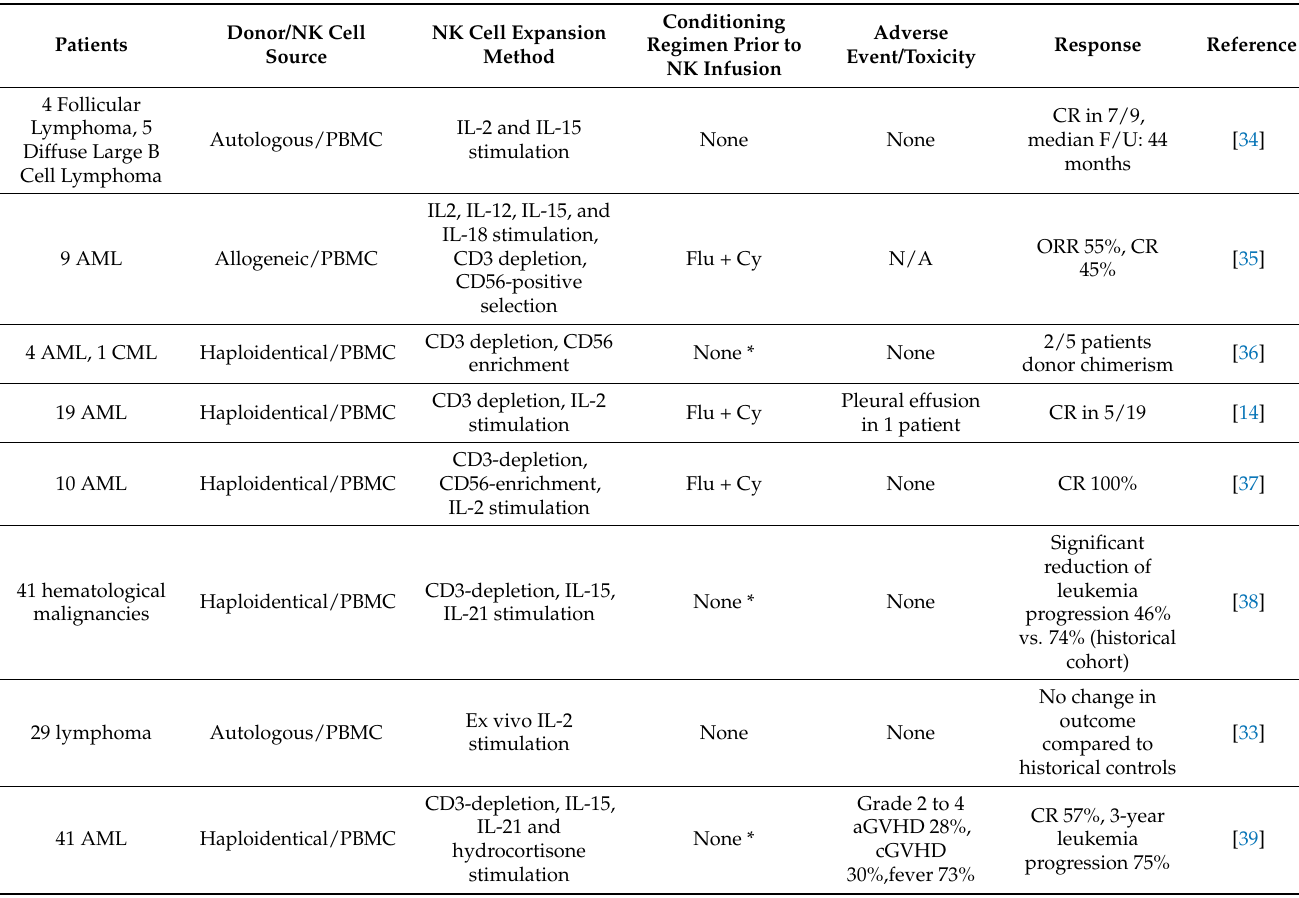
Table 1. Clinical trials with administration of autologous and allogeneic NK cells (aGVHD: Acute Graft versus Host Disease, AML: Acute Myeloid Leukemia, cGVHD: Chronic Graft versus Host Disease, CR: Complete Response, CRS: Cytokine Release Syndrome, CML: Chronic Myeloid Leukemia, Cy: Cyclophosphamide, DLI: Donor Lymphocyte Infusion, Flu: Fludarabine, F/U: Follow-up, GVHD: Graft versus Host Disease, iPSC: Induced Pluripotent Stem Cells, MDS: Myelodysplastic Syndrome, N/A: Not Applicable, NHL: Non-Hodgkin Lymphoma, ORR: Overall Response Rate, PBMC: Peripheral Blood Mononuclear Cells, R: Rituximab, SD: Stable Disease, UCB: Umbilical Cord Blood, * Posttransplant application). The numbers in the first column represent the number of